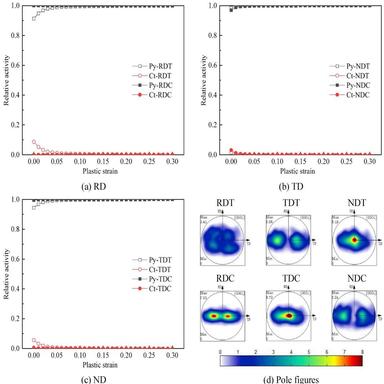
Relative activities of individual deformation modes under different loading conditions when only Ct and Py are activated in the thought experiment, and the predicted pole figures after 20% tension/compression along six directions. Ct contributes a little to deformation and the role of Py is overwhelming.